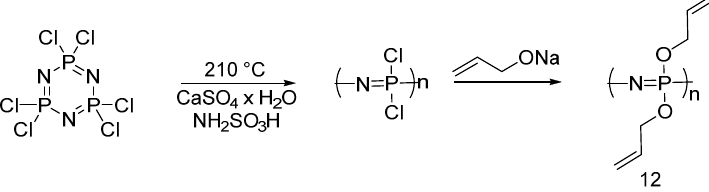
Figure 8. Synthesis of allyl-functionalized polyphosphazene ( 12 ).